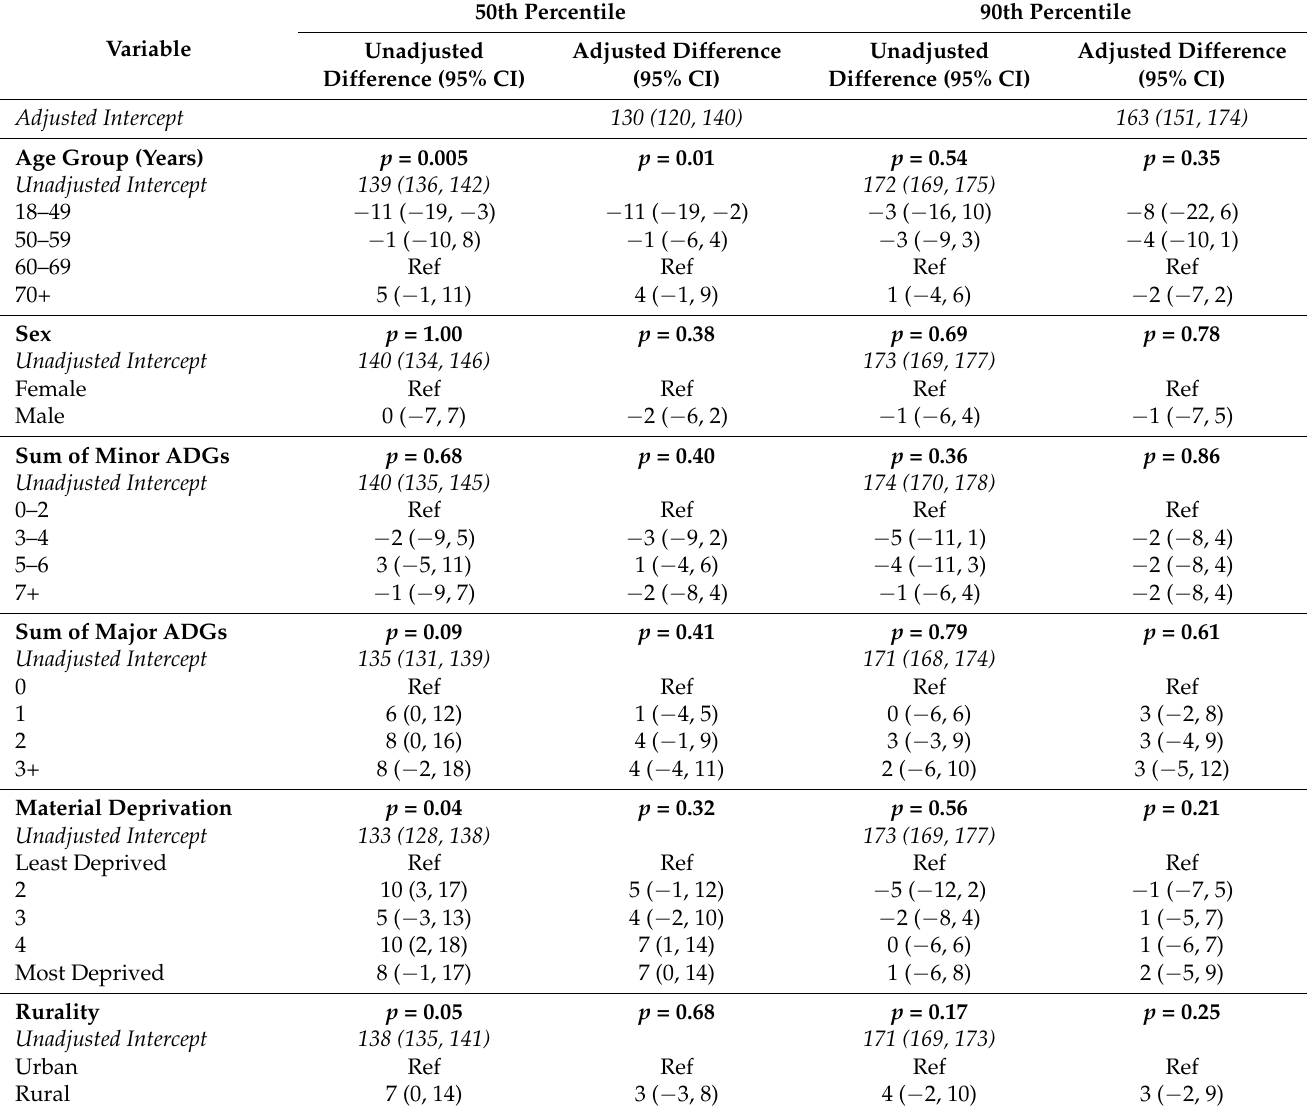
Table 3. Unadjusted and adjusted differences in TTS (days) at the 50th and 90th percentiles according to the factor categories in Ontario patients undergoing trimodal treatment for esophageal cancer between 2013 and